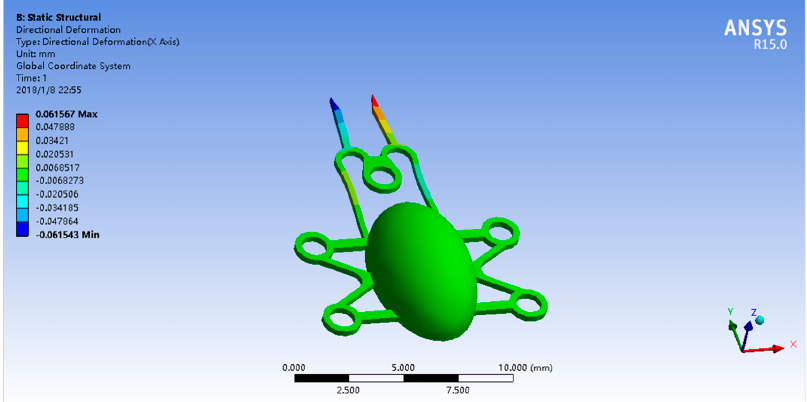
Figure 4. Gripper control simulation. The gap between the two thin beams increases approximately 123 µ m compared to the original position; compared to the size of bioparticles, this value is sufficient for